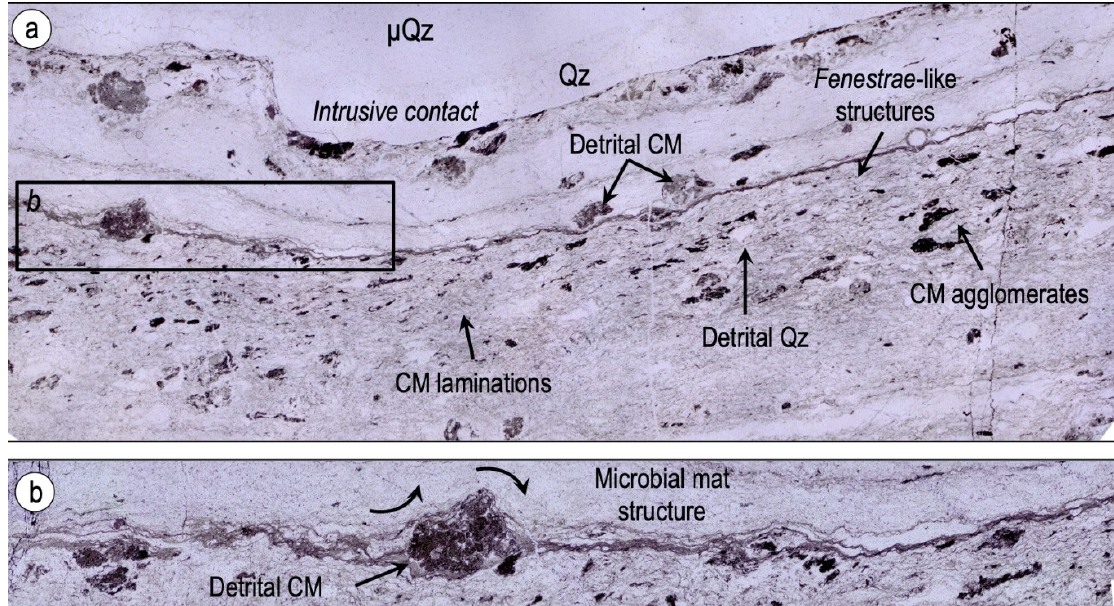
Figure 8. Massive black chert layer from the lower part of the Buck Reef. The top is truncated by a white chert vein. Image ( b ) is a detail of ( a ). The chert contains detrital rounded grains, elongated agglomerates and thin laminations of carbonaceous matter in a microquartzitic matrix. ( b ) Thin laminations draping detrital carbonaceous grains in a way similar to modern microbial mats. CM = Carbonaceous matter; µQz = microquartz; Qz = Quartz.